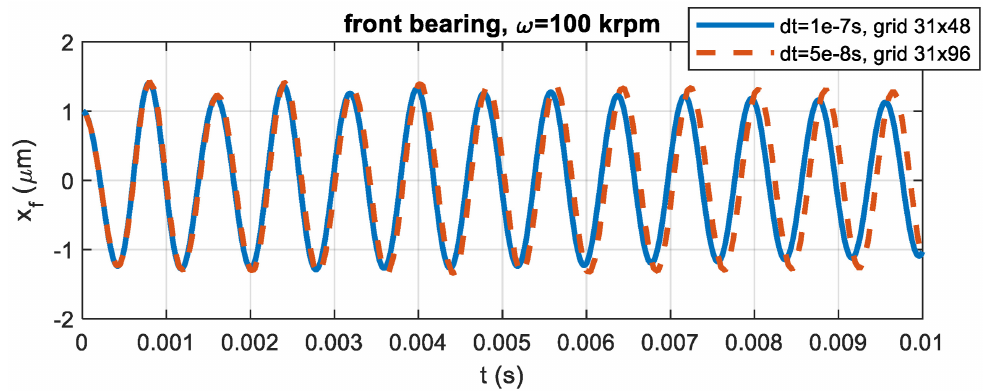
Figure 12. Comparison of vibrations obtained on front and rear bearings with 31 × 96 and 31 × 48 grids; the two curves match fairly well in case the time step is halved when doubling the grid